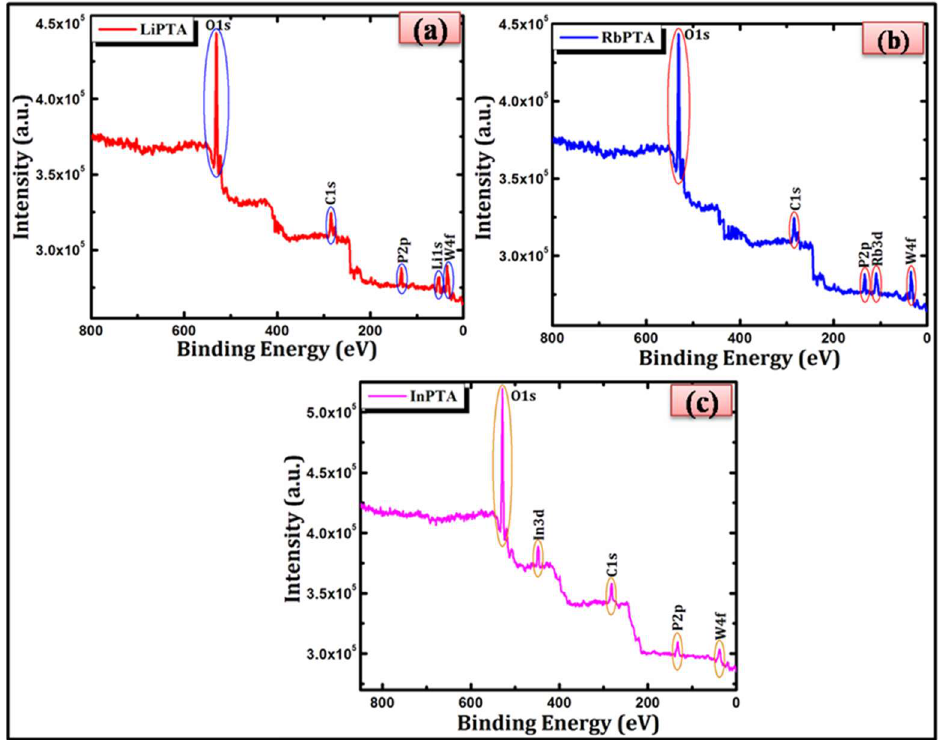
Figure 6. XPS survey spectra of ( a ) Li−PTA, ( b ) Rb−PTA, and ( c ) In−PTA thin films. Overall, the survey spectra for Li−PTA, Rb−PTA, and In−PTA -based thin films show they are composed of elements Li, Rb, In, P, W, and O ions are reliable in their arrange- ment for Li + , Rb + , In 3+ , P 5+ , W 6+ , and O 2− valence states, confirming that synthesized Li−PTA, Rb−PTA, and In−PTA thin films are consistent with their stoichiometric formula, Li 3 PW 12 O 40 , Rb 3 PW 12 O 40 , and In 3 PW 12 O 40 , respectively.